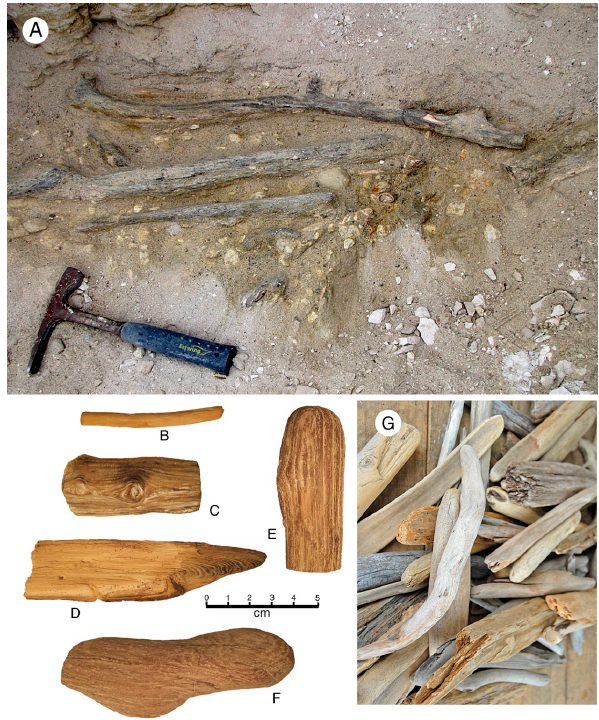
Figure 8. Bruneau Woodpile specimens have characteristics indicative of fluvial transport. Two morphotypes are common: elongate limbs ( A – C ) and irregular fragments of trunk wood ( D – F ). For both types, exterior surfaces have been smoothed by erosion, bark and side branches have been removed, and terminations are rounded. Elongate limbs ( A ) break into shorter segments during excavation from the matrix because of the brittleness of the phosphatized wood. These morphologies are identical to modern fluvial driftwood ( G ).